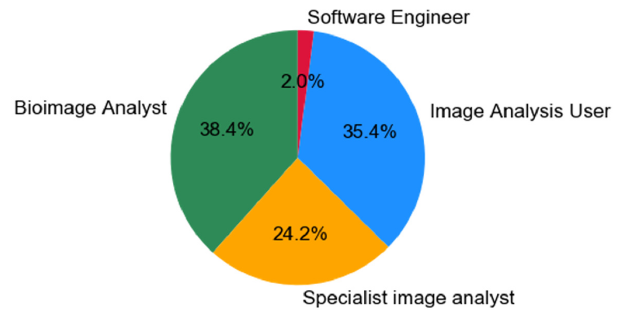
Figure 3. Pie chart representing answers from Q1.3. Participants were able to select only one